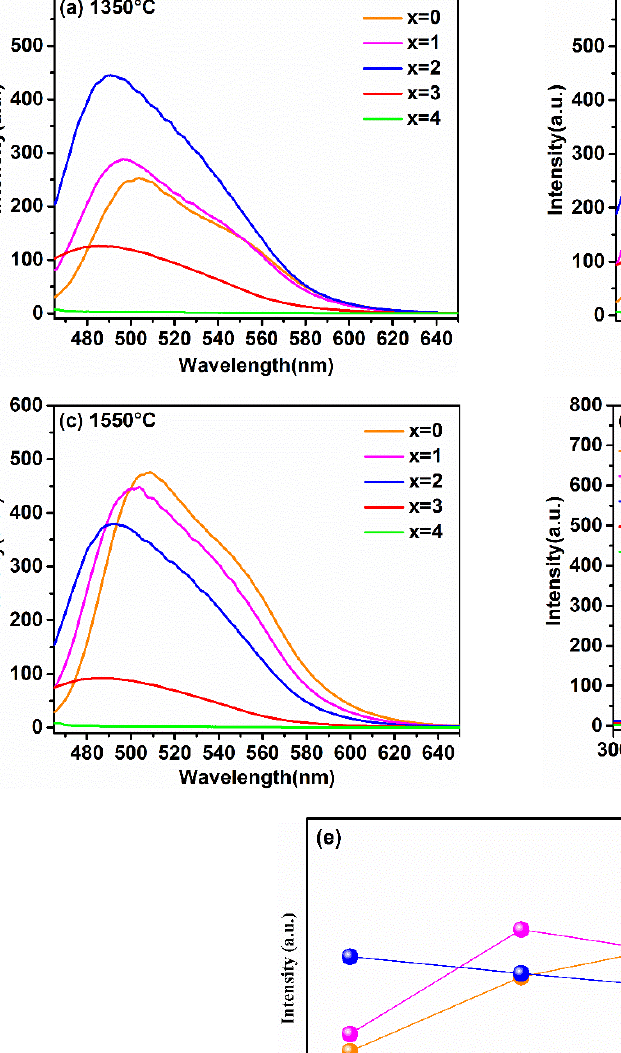
( c ) Figure 3. The SEM images of the Lu 3 Ga 2 Al 3 O 12 : Ce 3+ synthesized at ( a ) 1350 °C, ( b ) 1450 °C, and ( c ) 1550 °C for 3 h. 3.2. Photoluminescent Spectra In order to reveal the relationship between the luminescence properties, the concen- tration of Ga